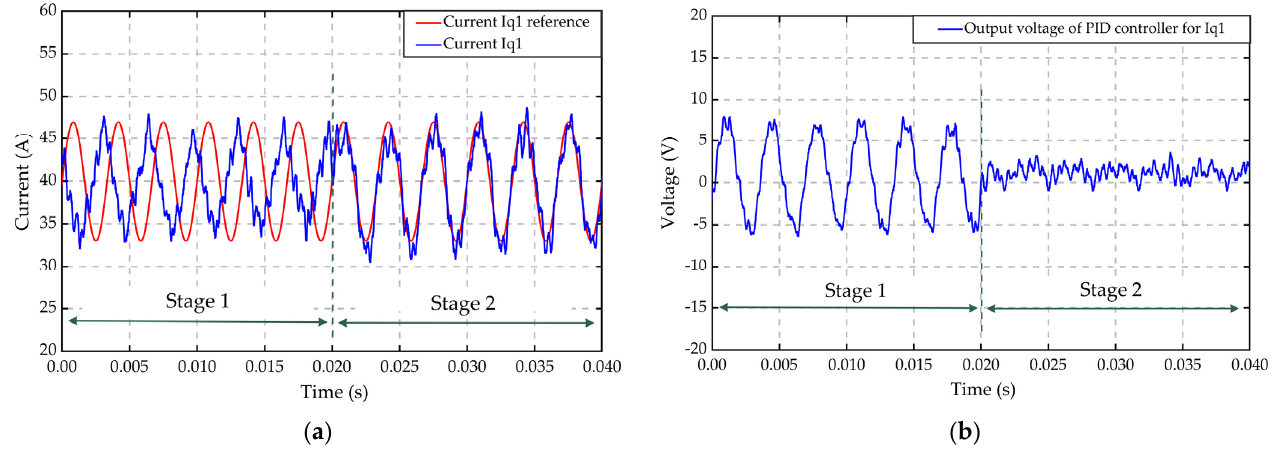
Figure 15. The dynamic response of the current and voltage on the q-axis under HFR measurement and torque ripple compensation conditions in two stages: ( a ) Reference and sampled current on q1-axis, ( b ) Q1-axis voltage produced by the PID controller.